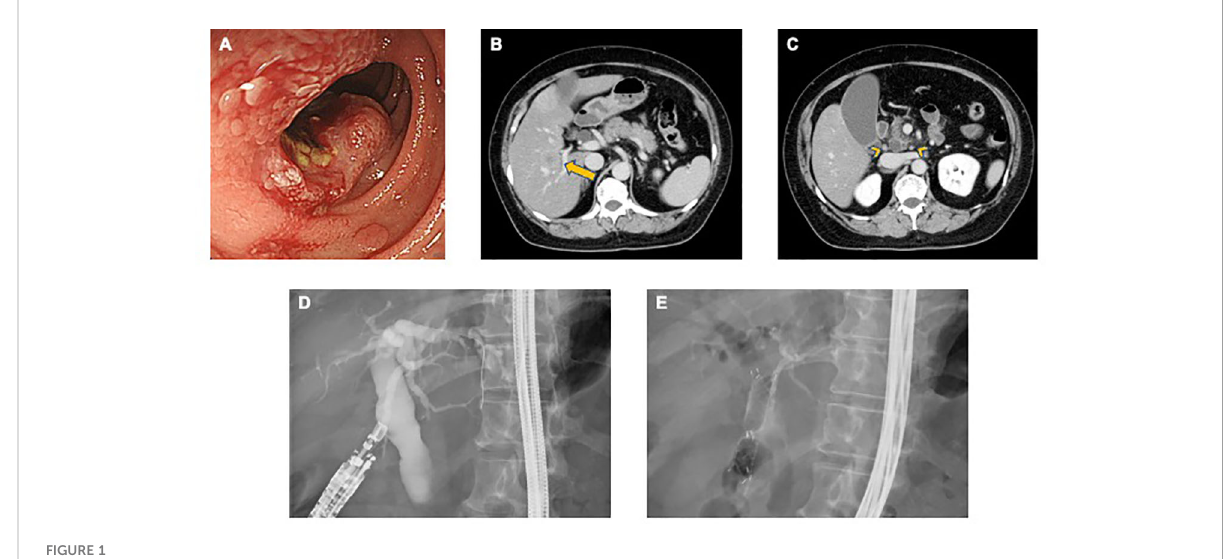
FIGURE 1 (A) Endoscopic fi ndings of the duodenum reveal a type 2 tumor on the descending part. (B, C) Abdominal computed tomography shows multiple liver metastases (long arrow) and lymph nodes (arrowhead). (D) After EUS-guided puncture, contrast agent was injected into the common bile duct for cholangiogram. (E) Choledochoduodenostomy was accomplished with a fully covered metallic stent through the duodenal